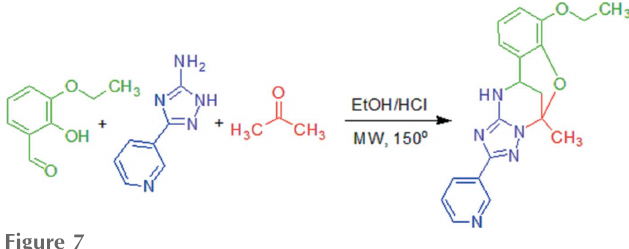
Figure 7 Synthesis of the title